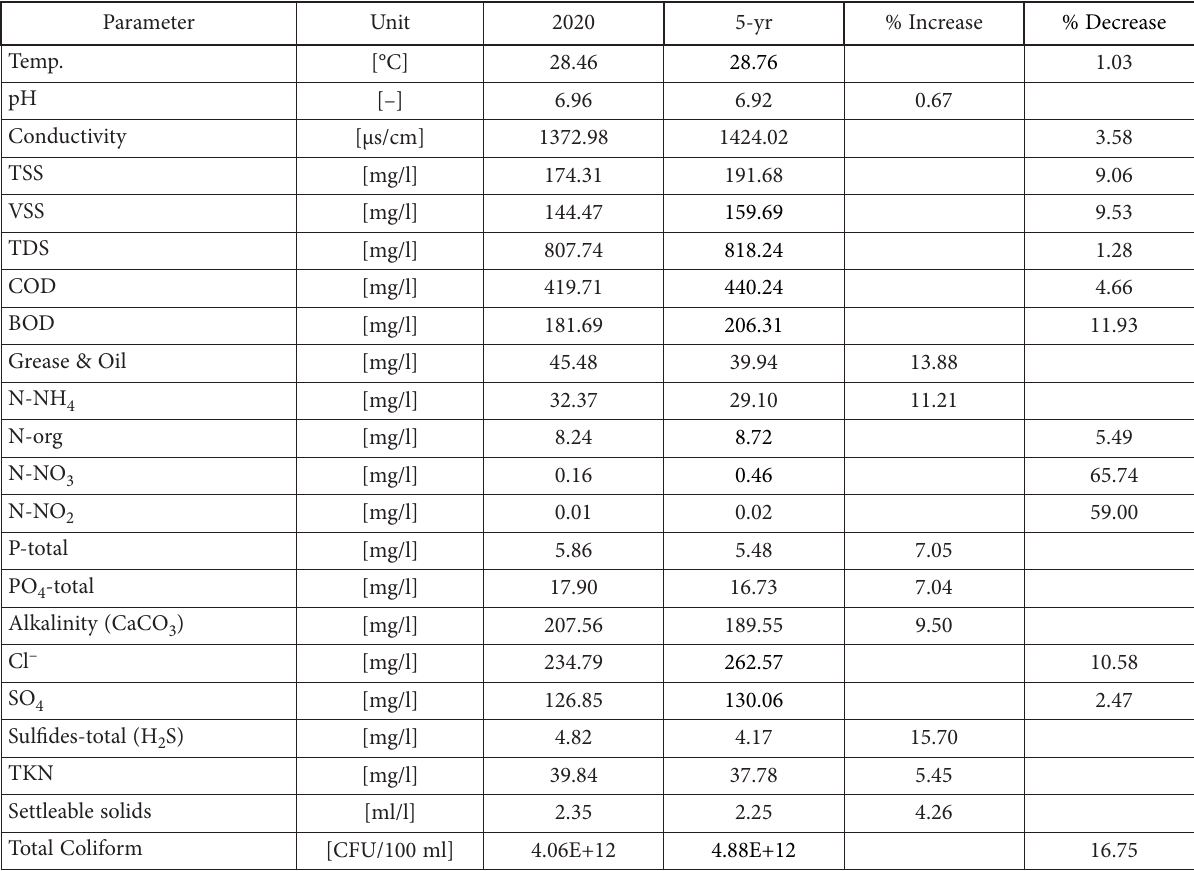
Table 3. Weighted 2020 and previous 5-yr wastewater parameters